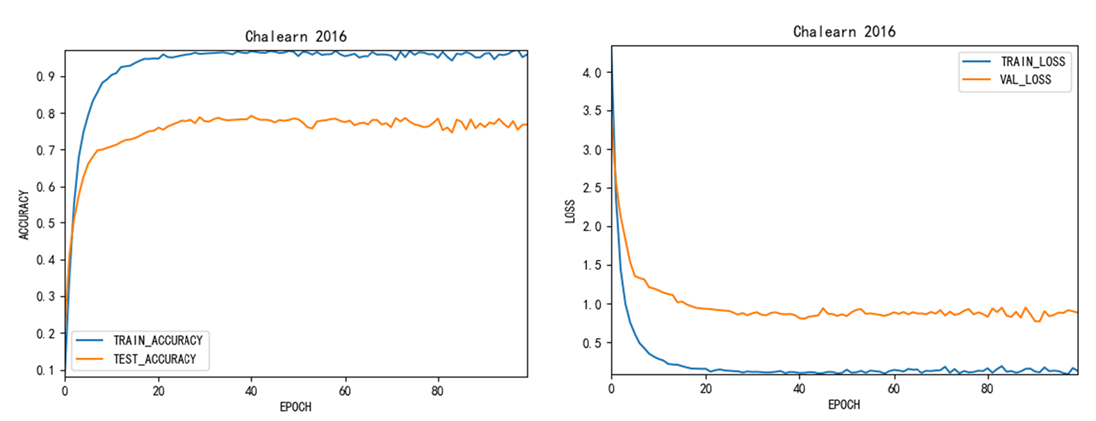
Figure 4. Accuracy on IsoGD dataset using MEMP network.